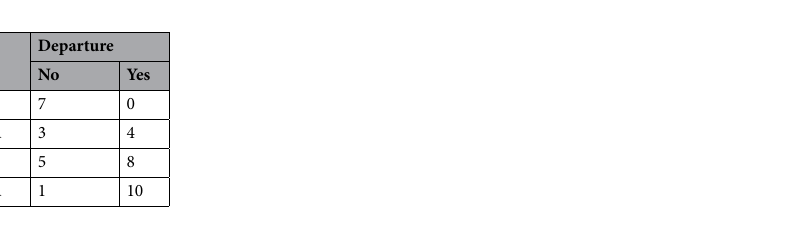
Table 3. Number of birds demonstrated take-off